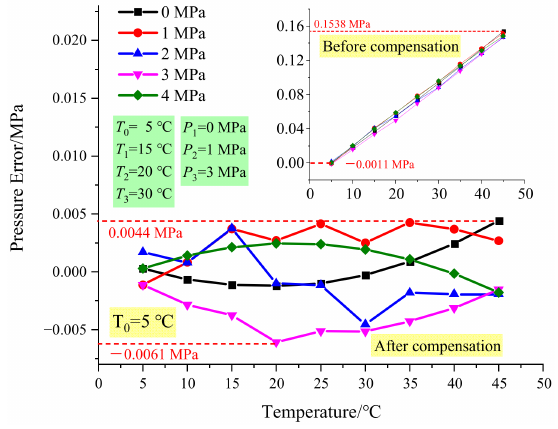
Figure 7. Errors when T 0 = 5 ◦